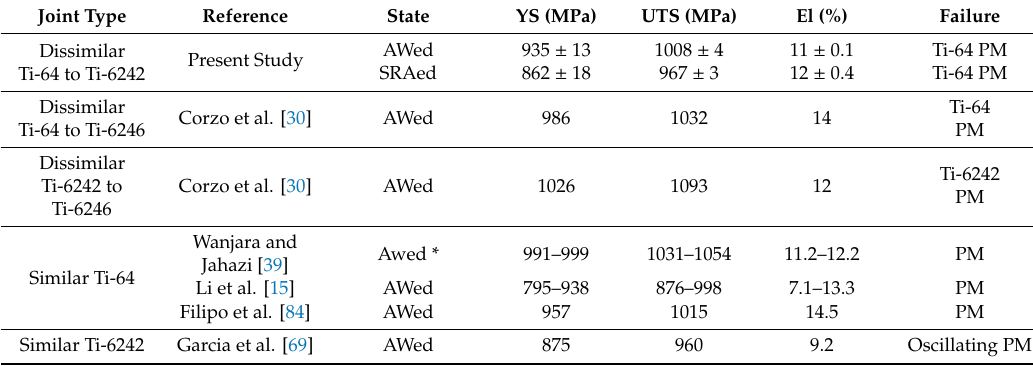
Table 6. Comparison of the tensile properties of similar and dissimilar titanium alloy linear friction